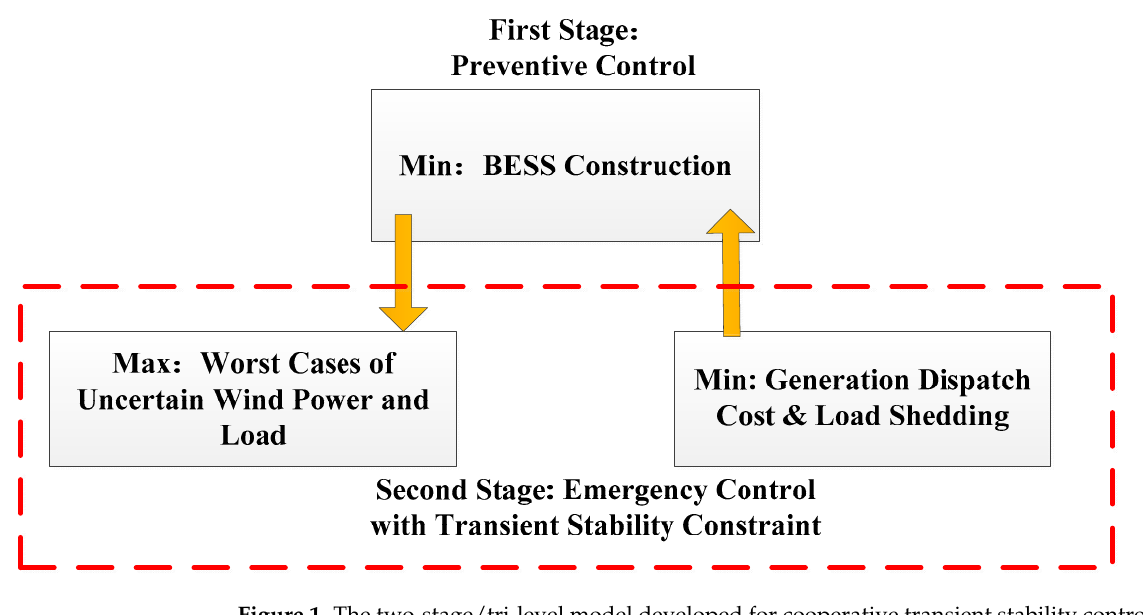
Figure 1. The two-stage/tri-level model developed for cooperative transient stability control.